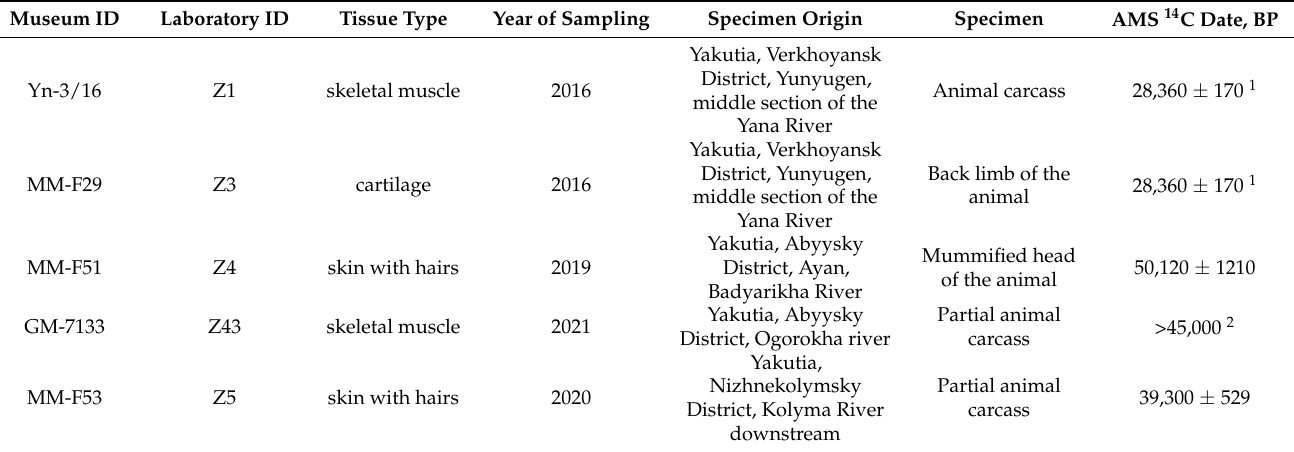
Table 1. Nomenclature and sampling location of the Don-hare specimens used in this